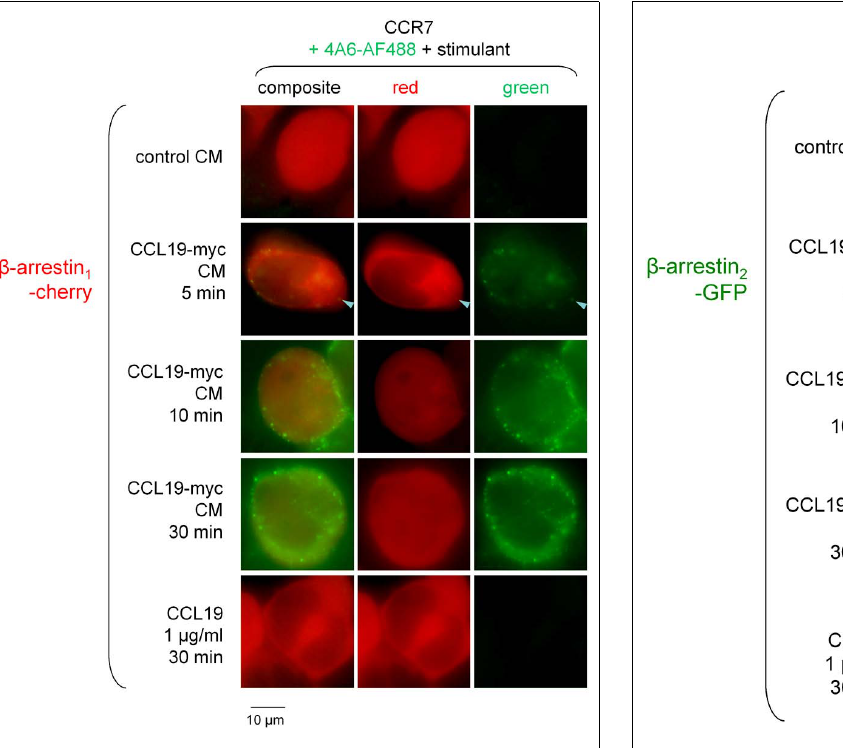
FIGURE 4 | Epifluorescence microscopy studies in cells co-expressing β -arrestin 1 -Cherry and CCR7 and stimulated as indicated (stimulant and duration). Stimulation always included the fluorescent anti-myc monoclonal antibody 4A6 (green signal). Either CCL19-myc CM or authentic CCL19 rarely condensed β -arrestin 1 at the level of plasma membranes of endosomes (arrowhead indicates possible co-localization with the CCL19-myc-antibody cargo). Cells that expressed well the red-emitting transgene were assumed to co-express co-transfected CCR7 and were evaluated for morphology ( n = 16–49 eligible cells per group).The average number of red condensed structures was 0.4 ± 0.4 in cells treated with control CM and did not vary significantly in all other groups (Kruskal–Wallis test).The average number of green condensed structures in cells treated with control CM was 0 per cell and varied significantly according to treatments ( p < 10 − 4 , Kruskal–Wallis test; p values for Dunn’s multiple comparison test for each value vs. that of control CM reported thereafter). There were 8.3 ± 1.7 green specs per cell ( p < 0.05), 25.8 ± 3.2 ( p < 0.001), 33.1 ± 4.4 ( p < 0.001), and 0 (N.S.) in cells treated with CCL19-myc CM for 5, 10, or 30 min, or with recombinant CCL19, respectively.